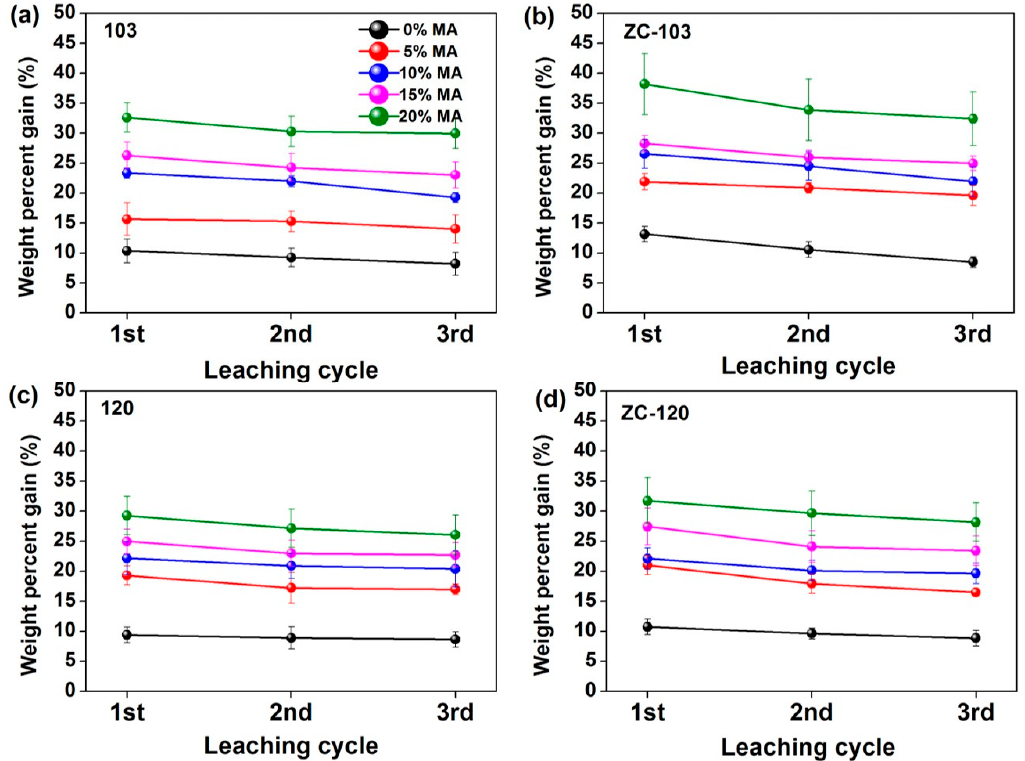
Figure 4. WPG of wood treated with different concentrations of maltodextrin (MA) and different treatments after three water leaching steps. The error bars represent the standard deviation of 20 replicates per treatment. ( a ) WPGs of 103 treatment after three leaching cycles; ( b ) WPGs of ZC-103 treatment after three leaching cycles; ( c ) WPGs of 120 treatment after three leaching cycles; ( d ) WPGs of ZC-120 treatment after three leaching cycles. Table 1. WPG of wood for different groups after leaching cycles.